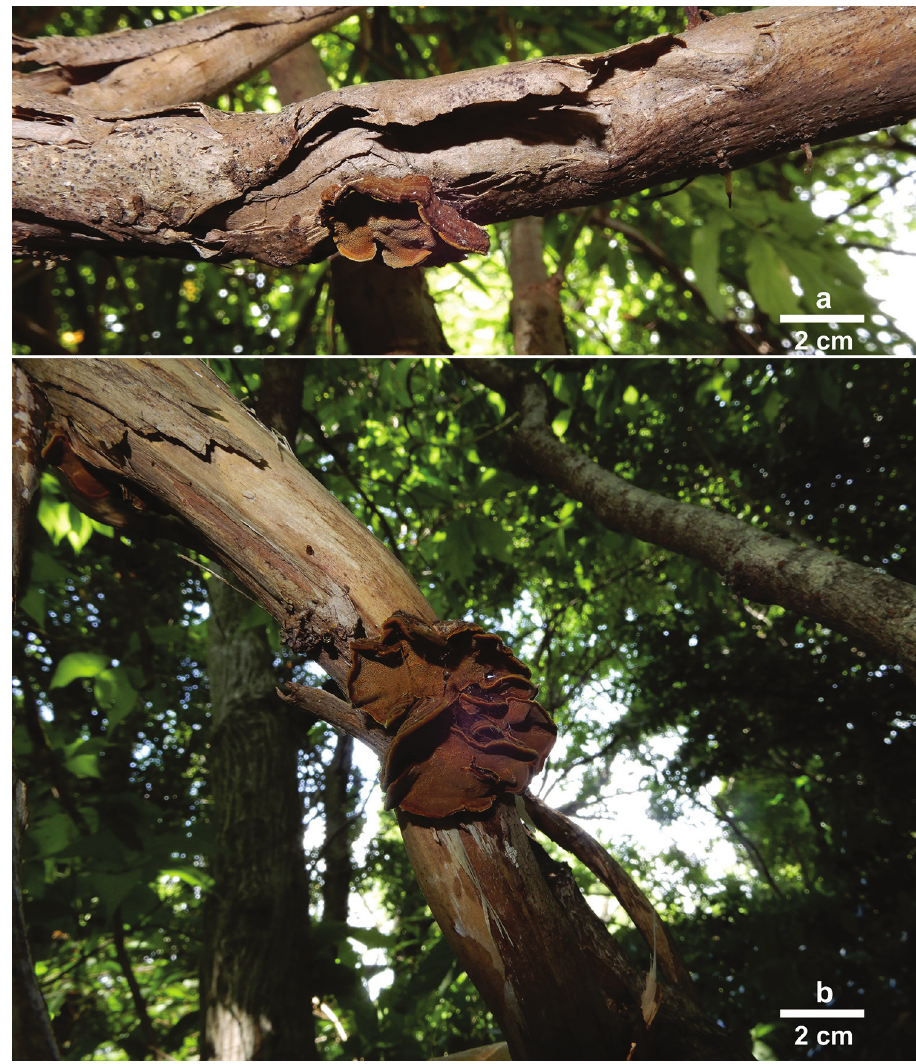
Figure 2. Basidiocarps of Phylloporia lonicerae in situ. a LWZ 20170703-2 (holotype) b LWZ 20170622- 1 (paratype). Scale bars: 2